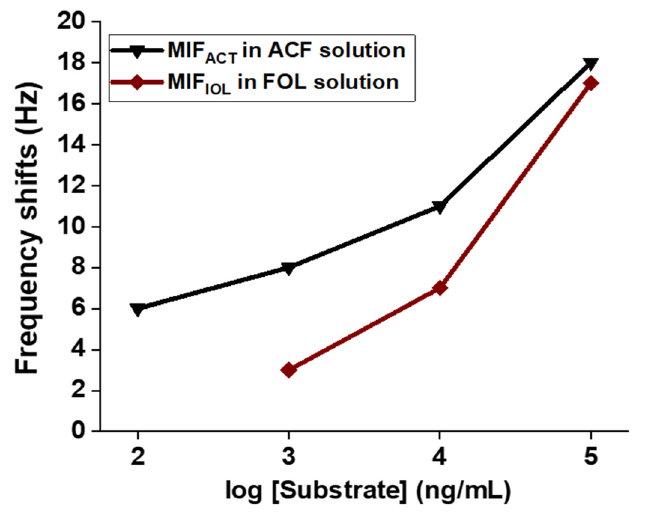
Figure 4. The frequency-shift results for the MIF ACT and MIF IOL templates, with a focus on the ACT and IOL binding to ACF and FOL, respectively, as obtained from MIF-QCM sensor. A mixed